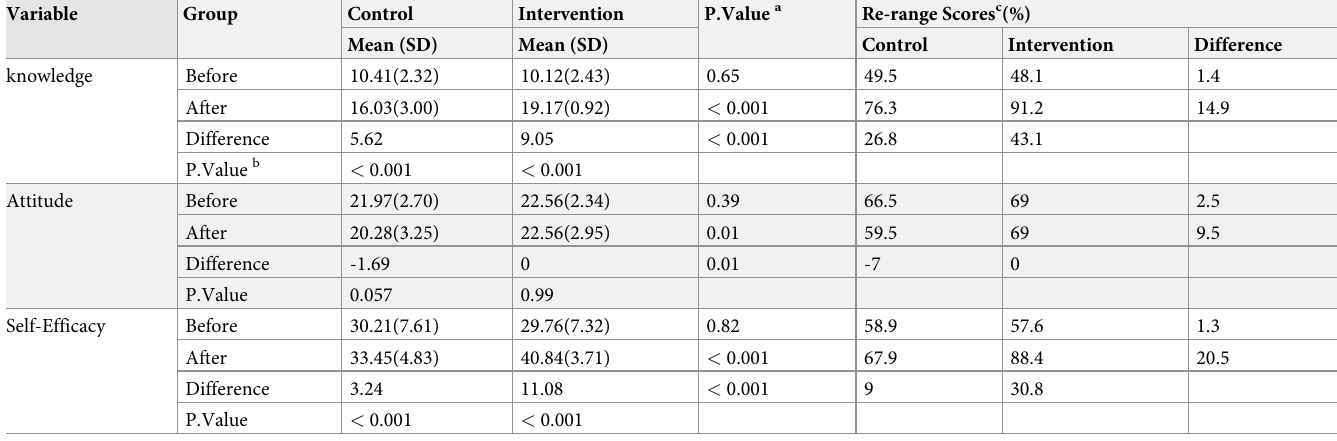
Table 2. Distribution of knowledge, attitude, and self-efficacy before and after intervention in the two groups. Variable